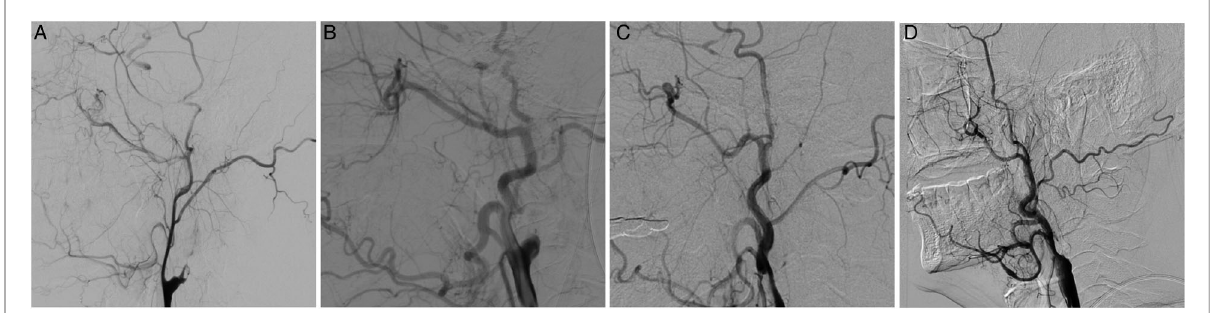
FIGURE 1 Illustration of the Hasan ’ classi fi cation of chronic internal carotid artery occlusion (CICAO). ( A ) Type A, taper stump; cavernous and/or petrous segments with collateral fi lling. ( B ) Type B, non-taper stump; cavernous and/or petrous segments with collateral fi lling. ( C ) missing stump; cavernous and/or petrous segments with collateral fi lling. ( D ) Type D: cavernous and/or petrous segments without collateral fi